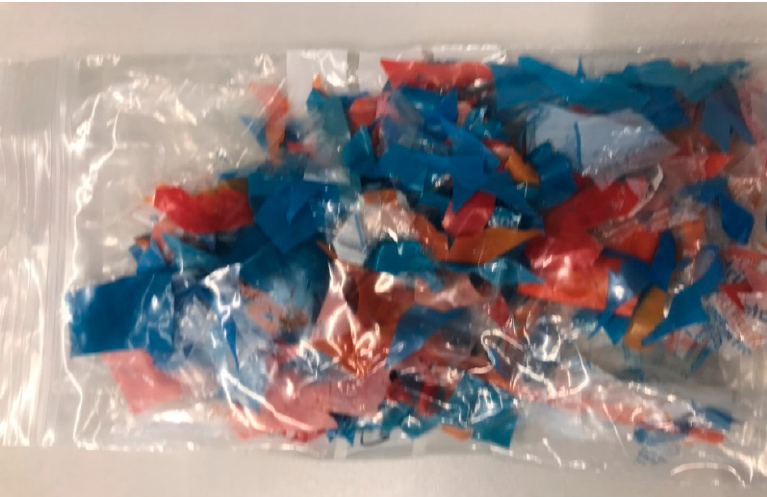
Figure 1. Shredded LDPE samples for the washing experiment .